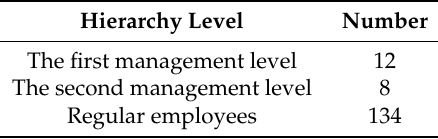
Figure 1. Organizational hierarchy after removal of former employees and technical accounts. Red nodes—first level management. Orange nodes—second level management. Blue nodes—regular employees. Table 1. Organizational structure after removal of former employees and technical